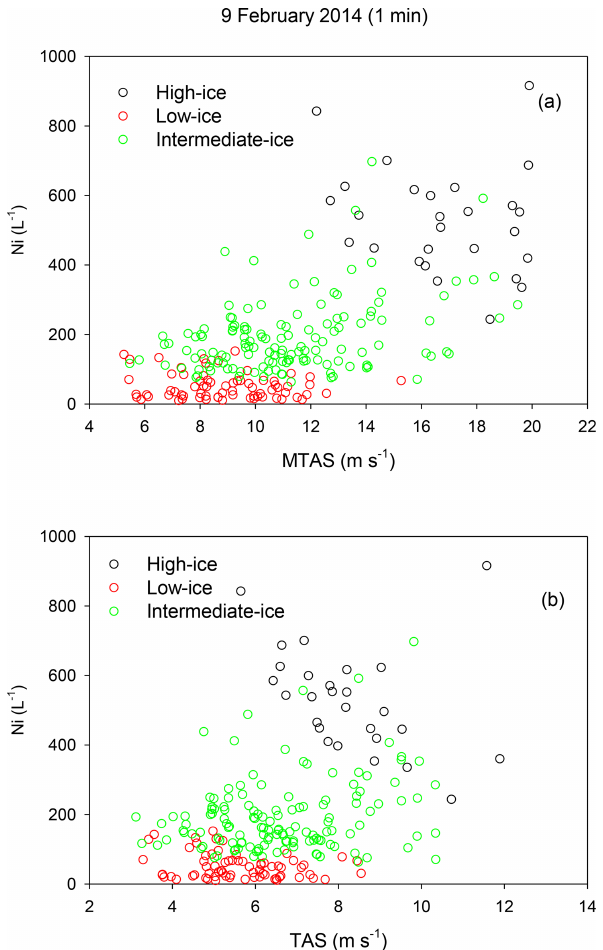
Figure 11. Relationships between 15s average N i and MTAS for high-ice (a) , low-ice (b) , and intermediate-ice (c) periods on 9 February